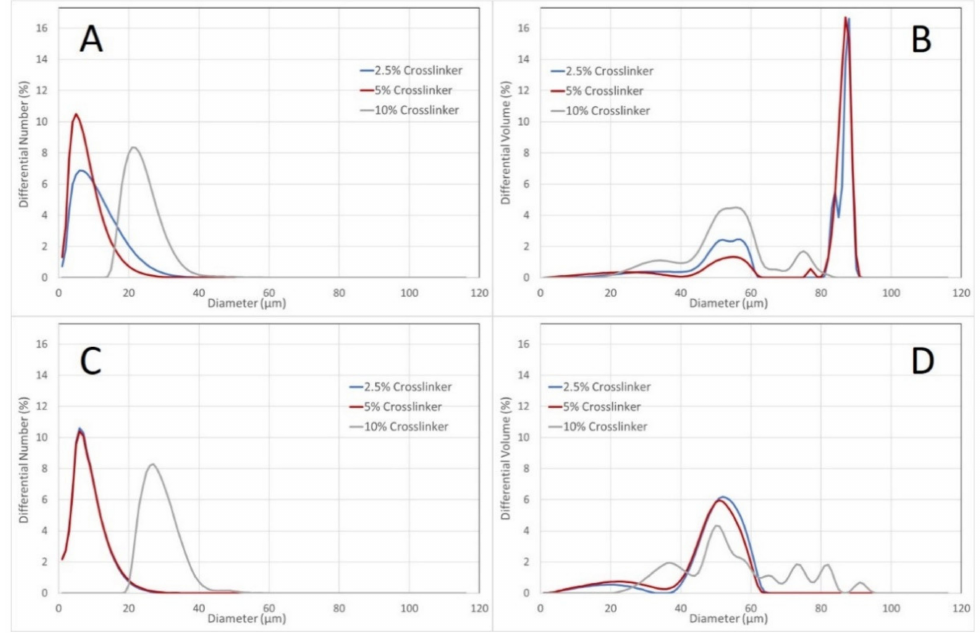
Figure 7. Size distribution of peppermint oil complex coacervate microcapsules with different crosslinker concentrations before ( A , B ) and after ( C , D ) spray drying as measured using laser diffraction.